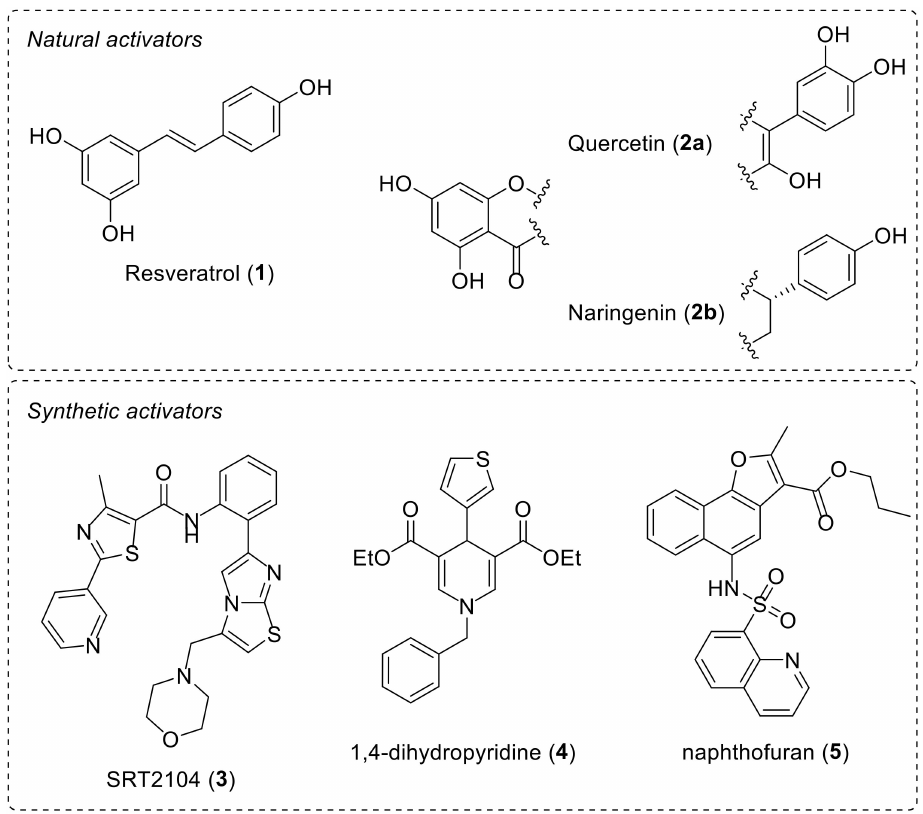
Figure 1. Chemical structures of some representative natural ( upper panel ) and synthetic ( lower panel ) SIRT1-activating